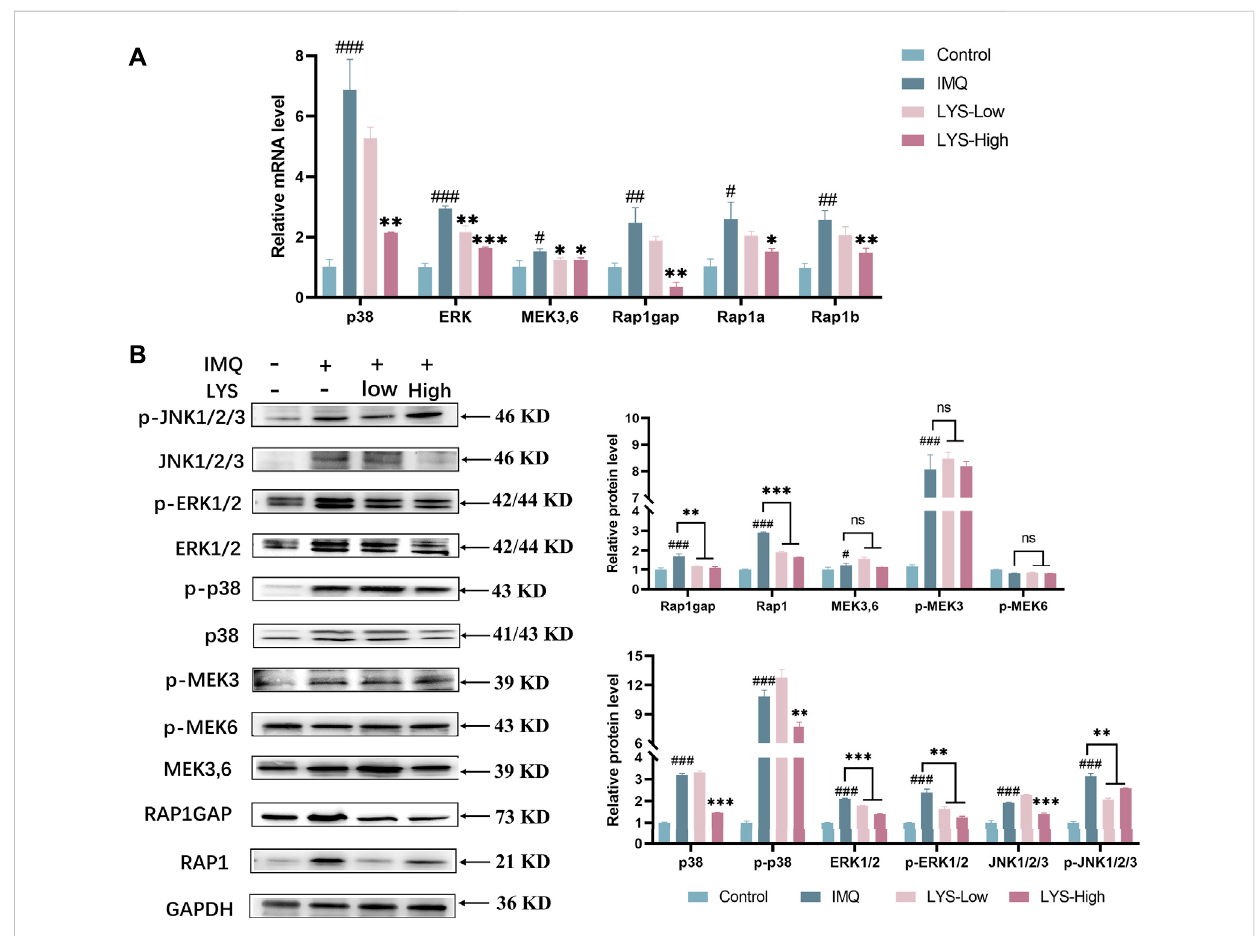
FIGURE 8 Effects of LYS on the expression of Rap1 (Rap1 and Rap1gap) and MAPKs (p38, JNK, ERK1/2, and MEK3,6) signaling pathways in the psoriasis-like mouse model. Expression of p38, ERK, MEK3/6, Rap1gap, Rap1a, and Rap1b mRNAs in the back skin tissues was detected using reverse transcription – polymerase chain reaction (A) and the relative protein expressionwas detected using WB (B) . The data are expressedas mean ± SD ( n = 3). # p < 0.05, ## p < 0.01, and ### p < 0.001 vs. the control group; * p < 0.05, ** p < 0.01, and *** p < 0.001 vs. the IMQ